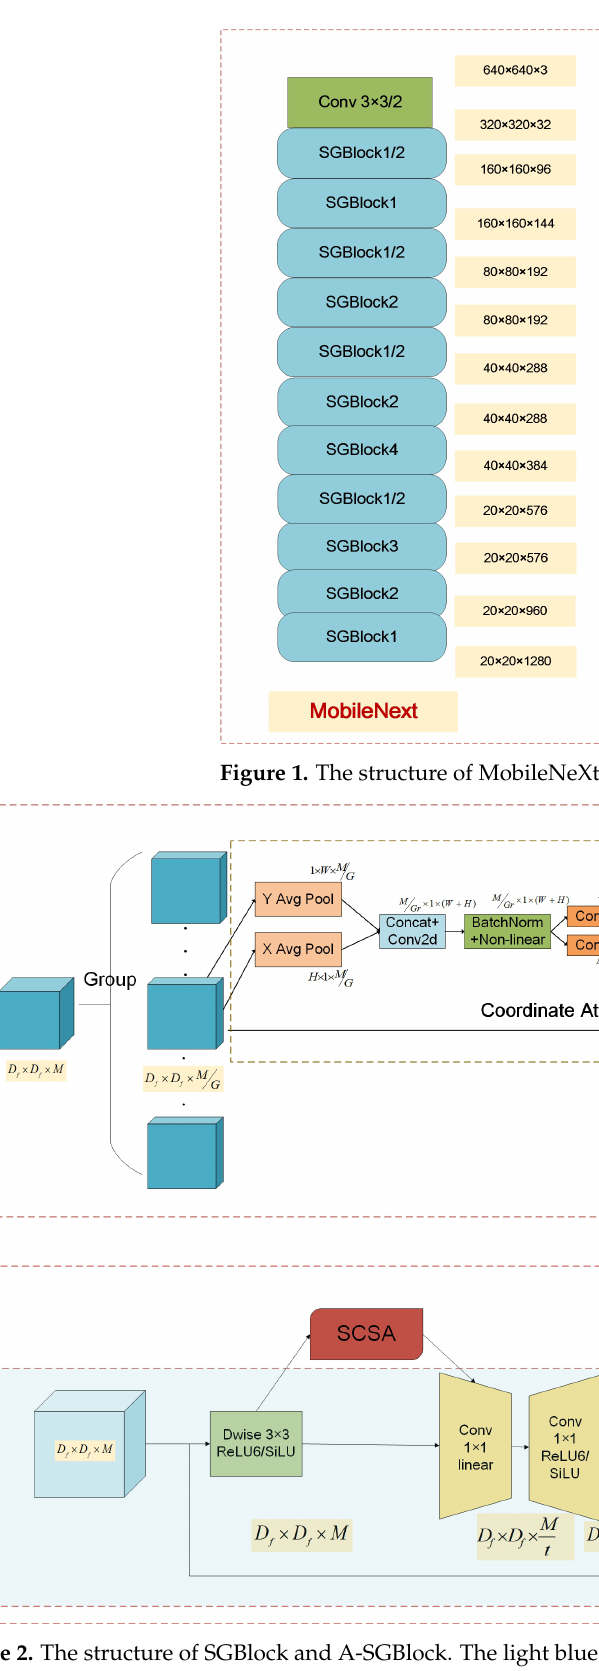
Figure 2. The structure of SGBlock and A-SGBlock. The light blue box represents the specific structure of SGBlock. Based on the SGBlock, A-SGBlock incorporates the SCSA module. SCSA represents the Shuffle Channel and Spatial Attention module. Coordinate Attention includes channel and spatial